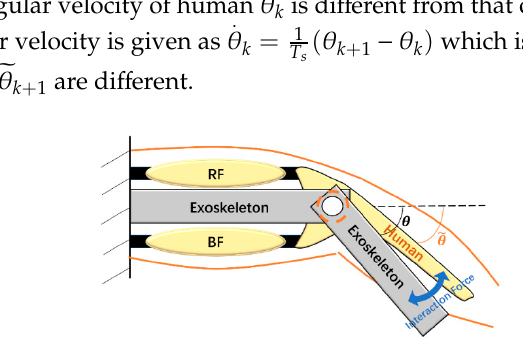
Figure 2. Mechanical approximation of the human knee joint and the rotational motion of human- Figure2. Mechanicalapproximationofthehumankneejointandtherotationalmotionofhuman-machine machine synthetic model. synthetic